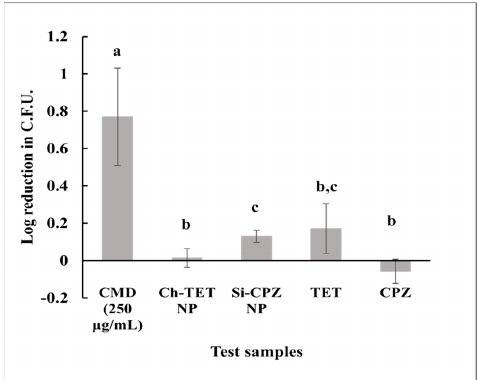
Figure 5. Effect of nanoparticle treatments on intracellular bacteria. Infected Caco-2 cells were treated with nanoparticle samples for 24 h. The cells were lysed, and the lysate was used to count the intracellular bacteria that survived. Log reduction was calculated. T -test was performed and p < 0.05 was considered significantly